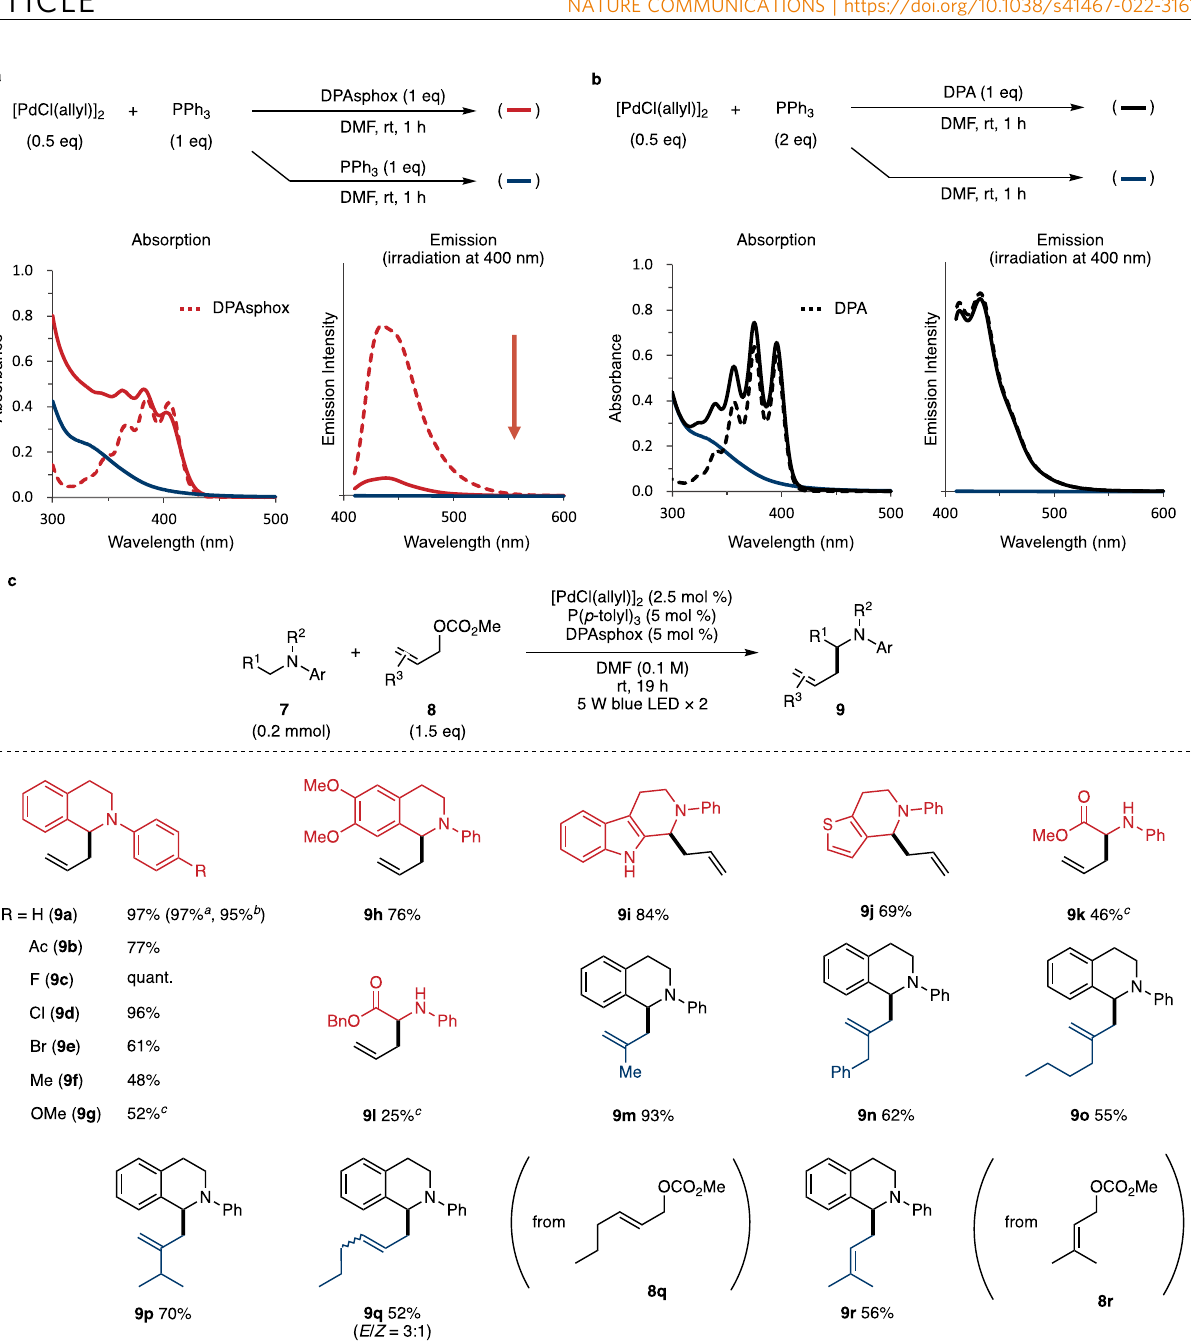
Fig. 3 Pd-catalyzed α -allylation of amines. a UV-Vis analysis with DPAsphox in DMF (0.05 mM). b UV-Vis analysis with DPA in DMF (0.05 mM). c Substrate scope. a 1.0 mmol scale. b Allyl alcohol was used instead of 8a . c 2,4,6-collidine (1 equiv.) was added. DMF N , N -dimethylformamide, DPA 9,10- diphenylanthracene, p -tolyl p